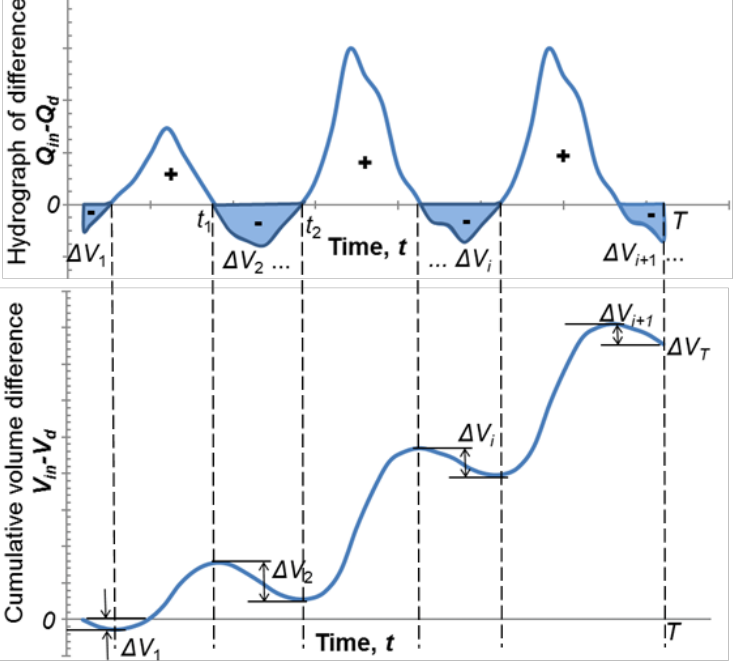
Figure 1. Temporal variation of net inflow and net cumulative volume.